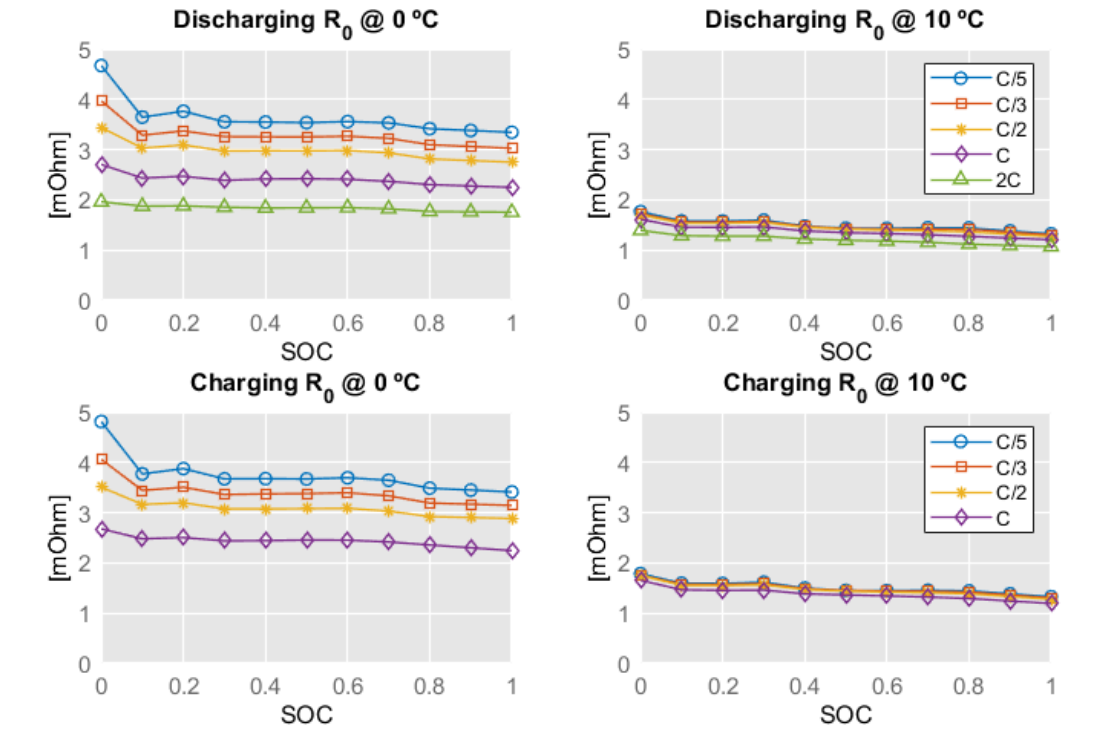
Figure 7. Ohmnic resistance ( R 0 ) in charge and discharge from HPPC test @ 0 – 10 °C.